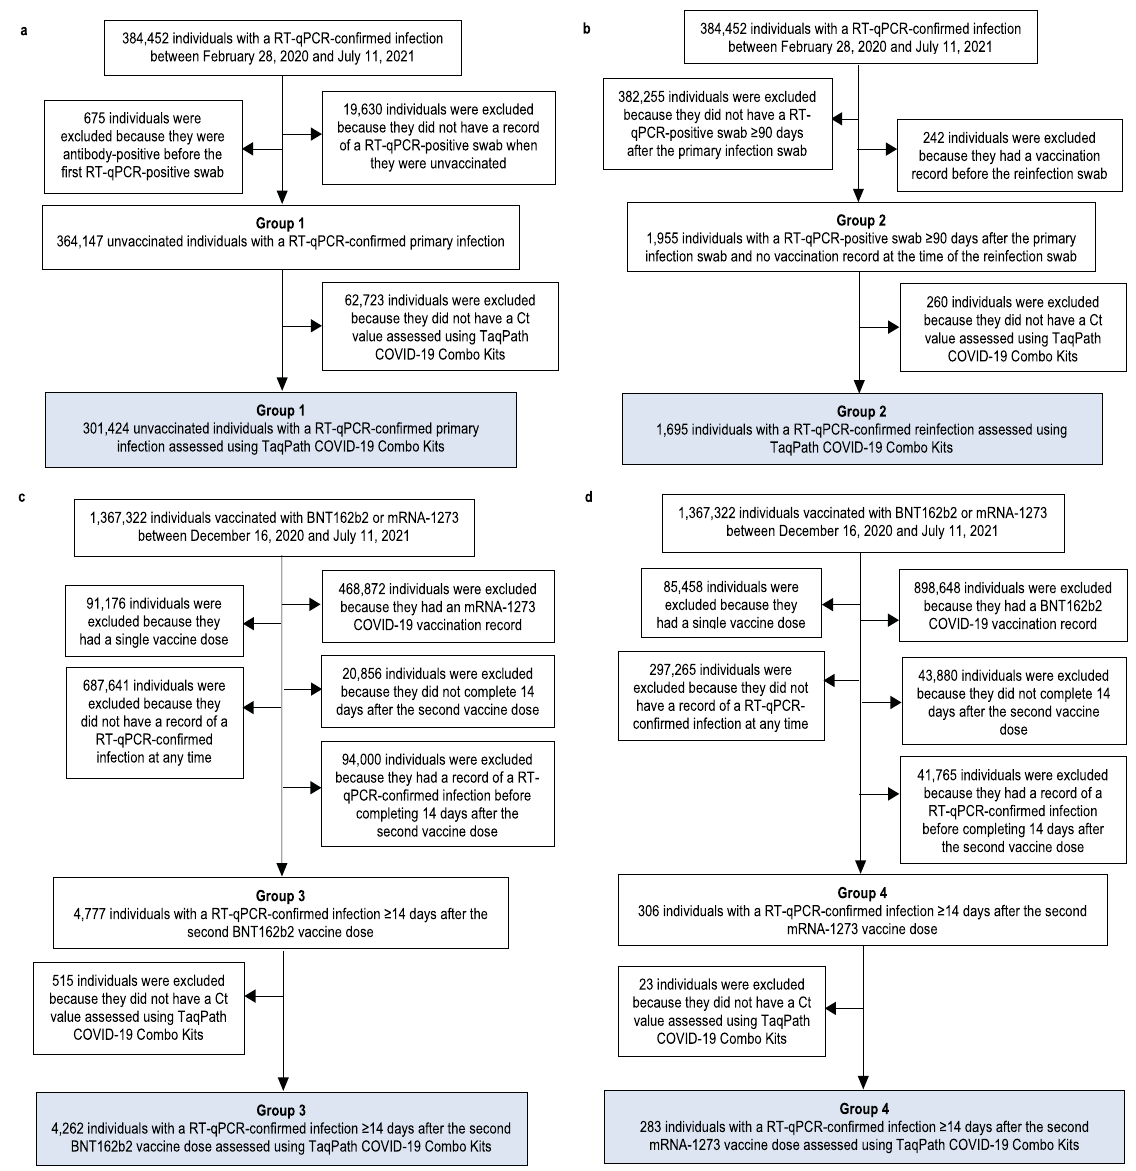
Fig. 1 Flowchart illustrating the population selection process. Flowchart illustrating the selection of the cohorts of ( a ) primary infections in unvaccinated individuals, ( b ) reinfections in unvaccinated individuals, ( c ) BNT162b2-vaccine breakthrough infections, and ( d ) mRNA-1273-vaccine breakthrough